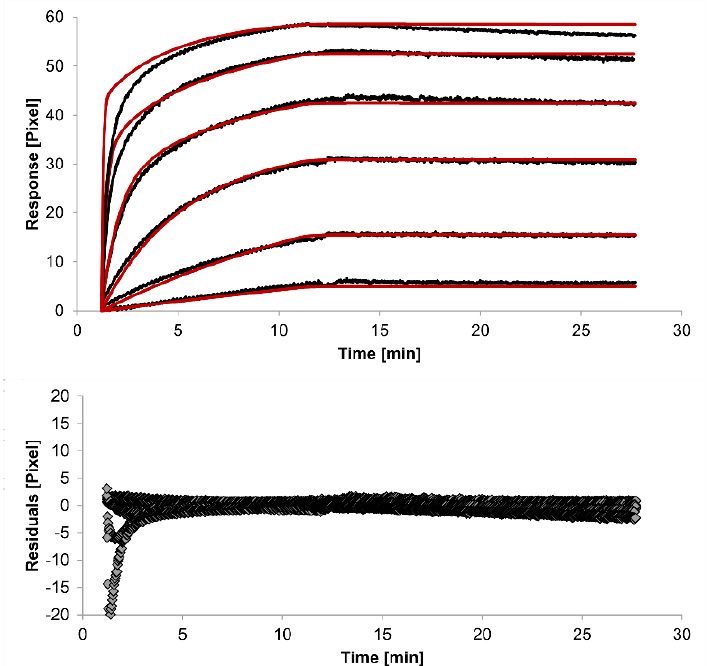
Figure 5. Kinetics of HSA-specific antibodies binding to immobilized HSA. Plots generated by globally applying the bivalent analyte model (red lines) overlay the plots associated with each antibody concentration (black lines; from top to bottom: 3.4 µM, 0.9 µM, 0.2 µM, 53.9 nM, 13.5 nM, 3.4 nM). Values resulting from the average of two sensing spots and